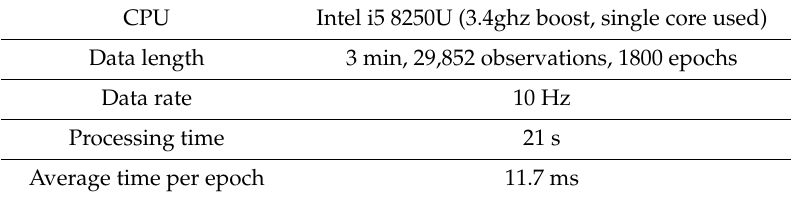
Table 3. Configuration and results to test the SVM based classifier prediction